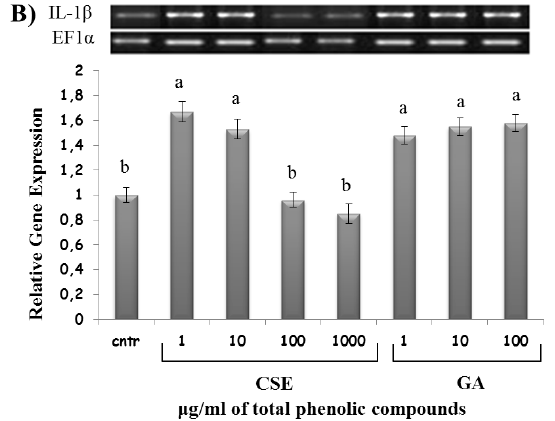
Figure 7. IL-1 β mRNA expression in response to different doses of CSE and GA in in vitro incubations of intestinal intraepithelial non-adherent leukocytes ( A ) and blood non-adherent leukocytes ( B ) of rainbow trout. The data represent the mean ± SD of different fish samples ( n = 9). Different letters on